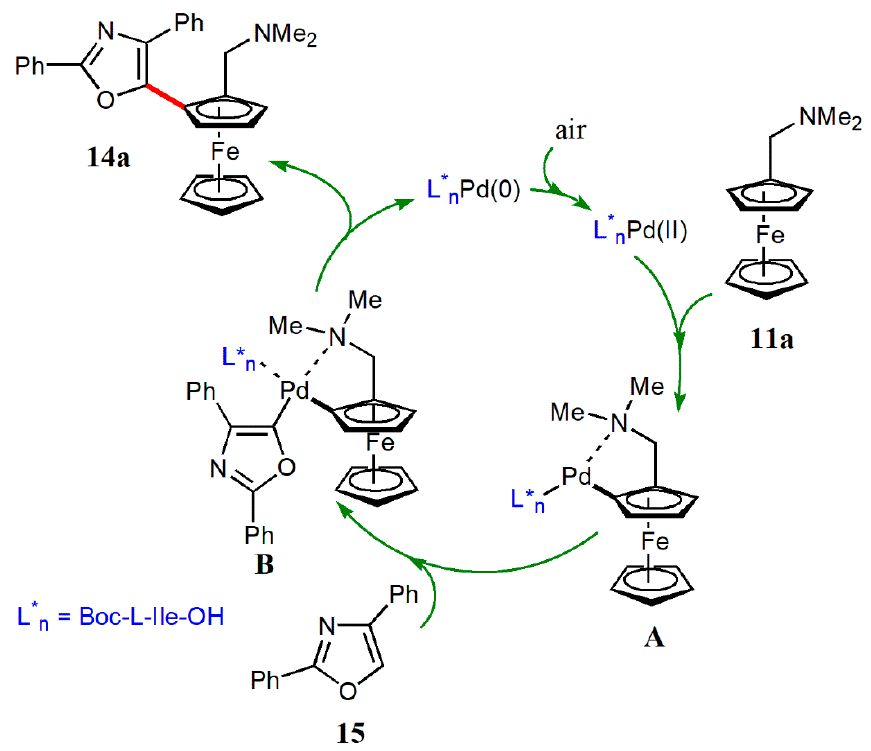
Figure 7. The mechanism proposed for the enantioselective CDC between ferrocenes and azoles.